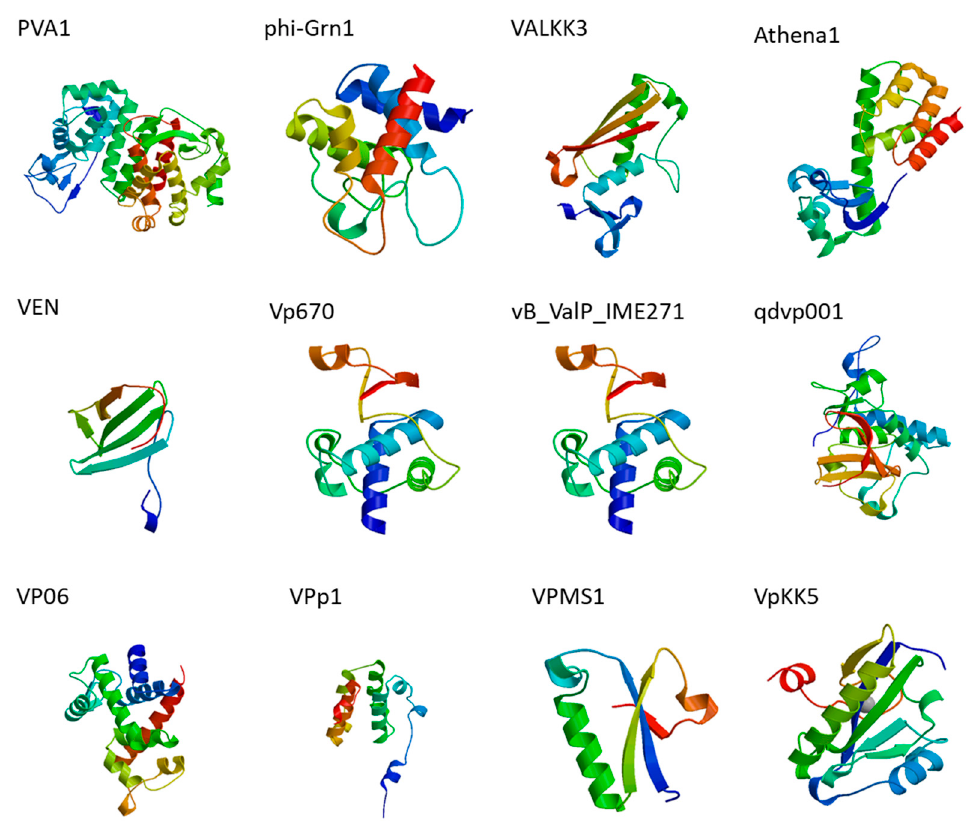
Figure 1. Structural modeling of Vibrio phage endolysins.